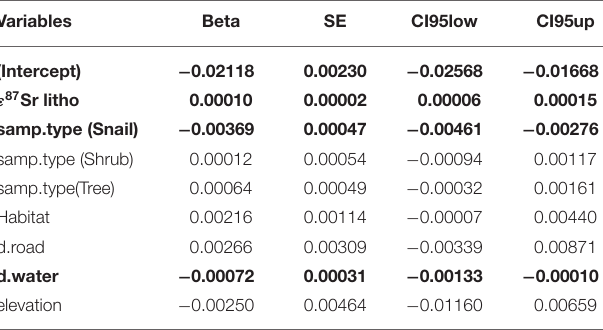
TABLE 2 | Parameters estimates from the best mixed-effects models (random factor: sampling site) explaining variation in the 87 Sr/ 86 Sr ratio of biological samples expressed in -( ε 87 Sr) − 1 .